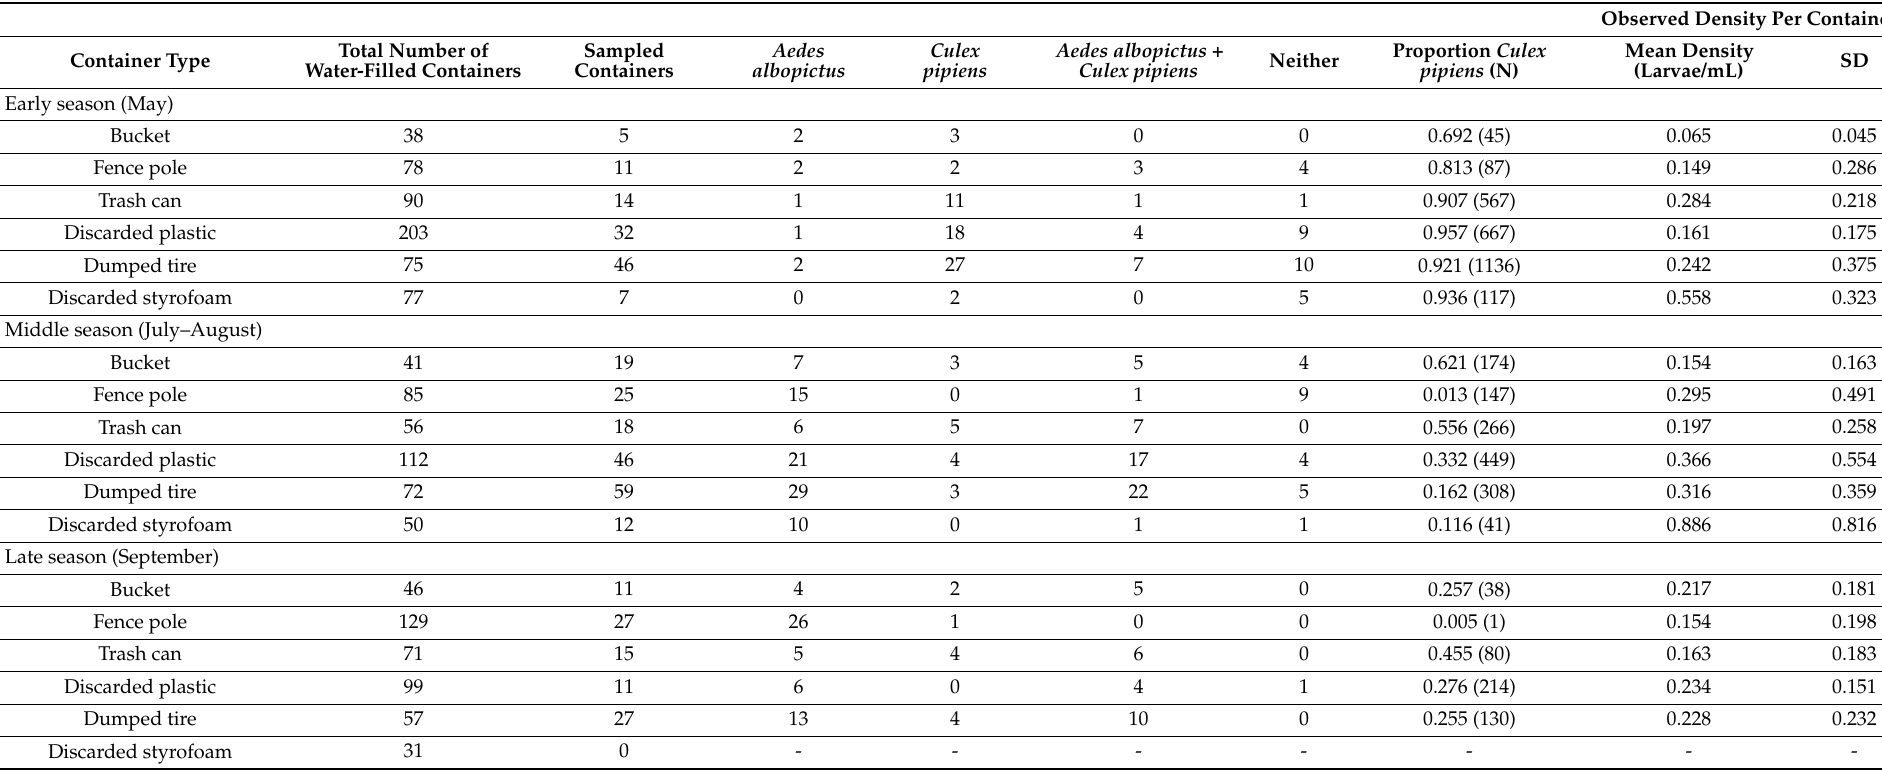
Table 1. Sampled density of mosquito larvae per container in each container type in 2014. Mean densities per container and SD are determined for occupied and sampled containers only.